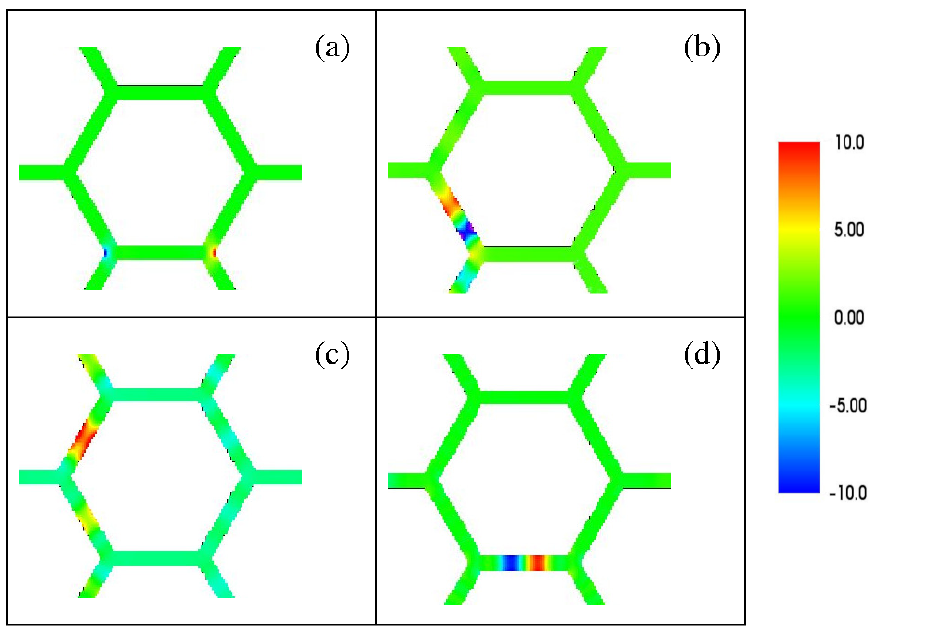
Figure 4. Profiles of several modes of the Fibonacci array calculated at r = 1. Only the portion of the array where the mode is located is shown. The color scale represents the real part of the perpendicular magnetization (arbitrary units); generally, the imaginary part is out-of-phase and has the same localization. ( a ) mode localized at the vertex of the hexagon base (antisymmetric, in this case, 8.621 GHz); ( b ) mode with one node located on a lateral edge (13.393 GHz); ( c ) uniform mode (zero nodes) located on a lateral edge (13.825 GHz); ( d ) mode with one node located on a base (17.210 GHz). The 1 KOe external field is applied in the horizontal